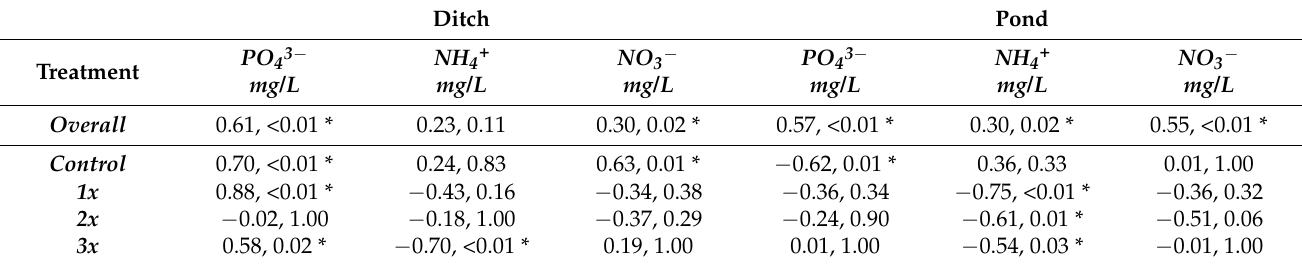
Table 3. Pearson’s correlations ( r , p ) of DOC (mg/L) with other nutrient compounds in both the ditch and pond habitats. Significant relations indicated with an